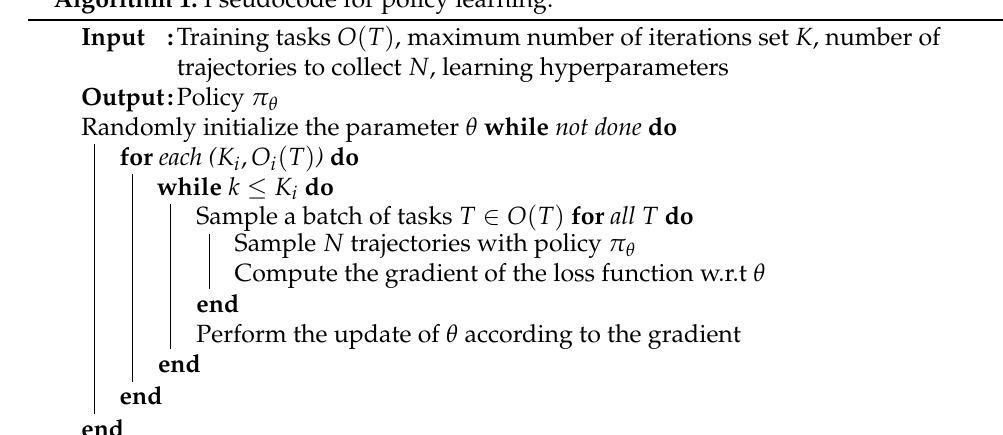
Algorithm 1: Pseudocode for policy